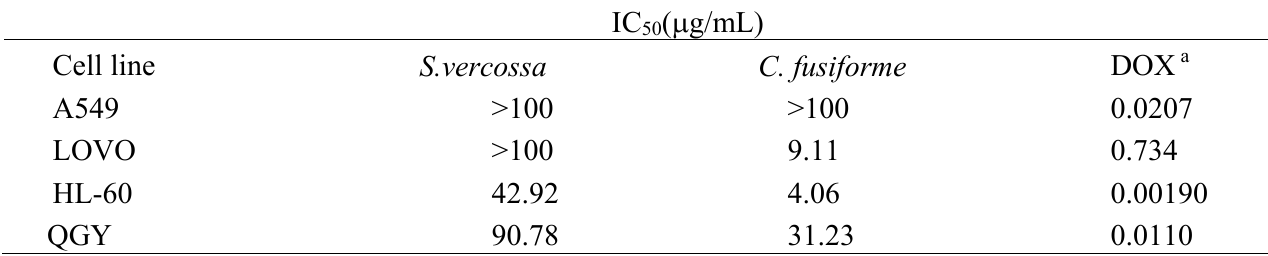
Table 4. Antitumor activity of the ether extract of S. verrucosa and C. fusiforme